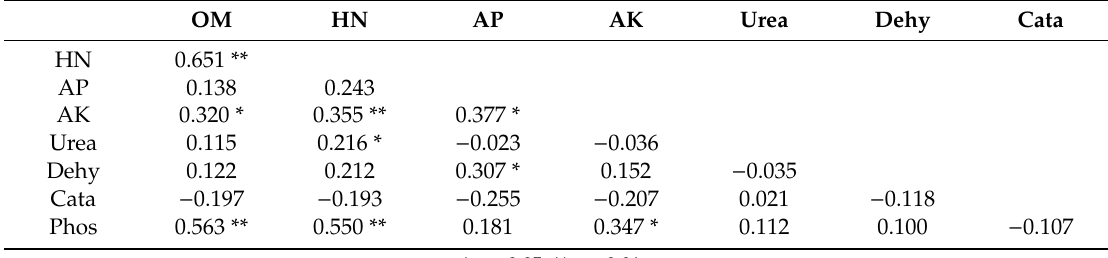
Table 3. Pearson correlations of soil chemical properties with different graphene treatments. Organic matter content (OM), hydrolytic nitrogen content (HN), available phosphorus content (AP), available potassium content (AK), dehydrogenase activity (Dehy), catalase activity (Cata), urease activity (Urea), and acid phosphatase activity (Phos).